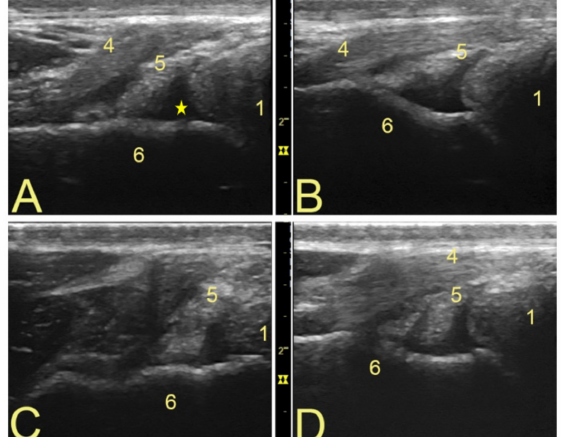
Figure 2. Variants on popliteal tendon structure and aspect of the subpopliteal recess. The variants on tendon components were identified with a transverse view. This view also shows hypoechogenic synovial fluid within the subpopliteal recess. Cranio-proximal is to the left. ( A – D ) Different tendon shapes and components (7). The LCL also changes in aspect according to the placement of the probe, as it changes according to the insertion type of the PopT. Annotations: 1—lateral meniscus; 4—LCL;